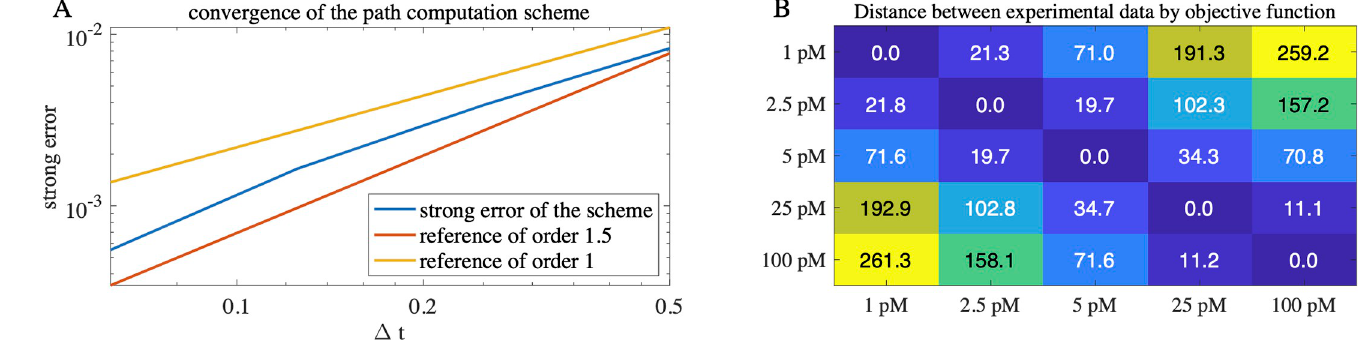
)| with respect to t − X ref